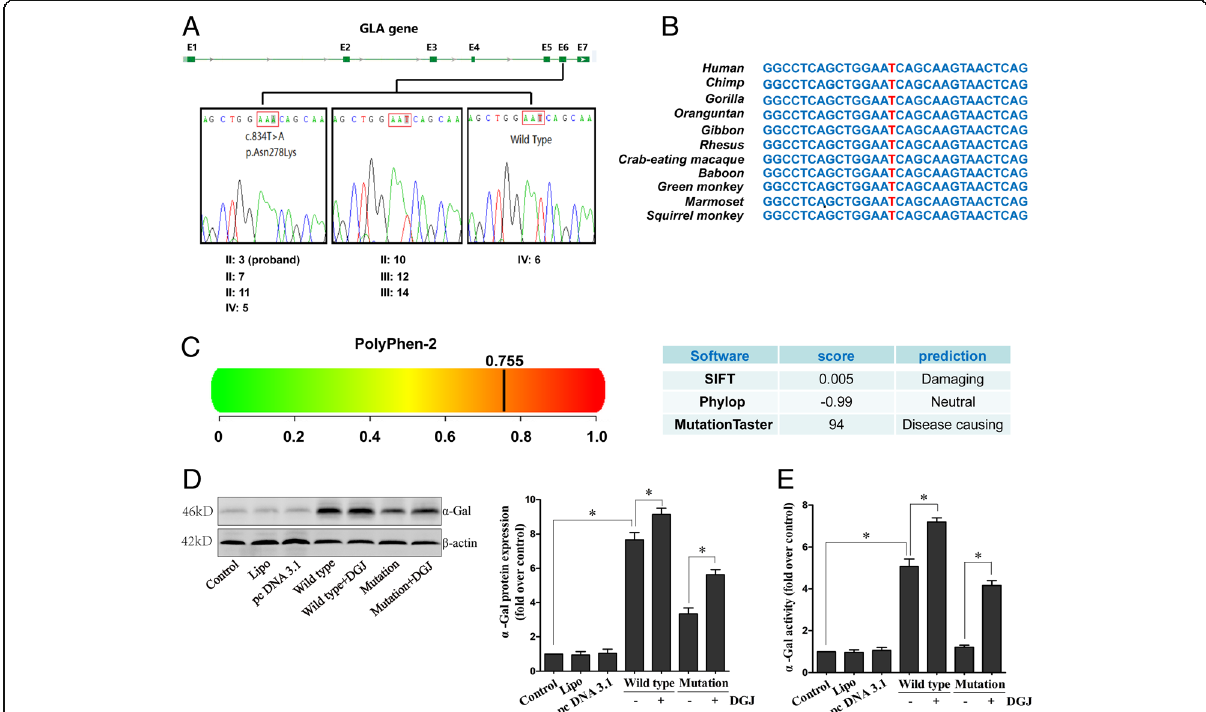
Fig. 3 Genetic screening and functional identification. a DNA sequences of the p.Asn278Lys site and adjacent bases of the eight subjects enrolled in the present study. b Genome Browser database of vertebrate species at the p.Asn278Lys mutation site and surrounding sequences. c In silico bioinformatic predictions for the function of the p.Asn278Lys mutation were made by four independent software packages: Polyphen-2, SIFT, Phylop, and MutationTaster. d Representative immunoblots and quantitation of α -Gal A protein expression with or without DGJ treatment in HEK293T cell lines transfected with GLA-Asn278 or GLA-Lys278. e Measurements of α -Gal A enzyme activity with or without DGJ treatment in KEK293T cell lines transfected with GLA-Asn278 or GLA-Lys278. Data are expressed as the means ± SD, n =3 for each group, * p